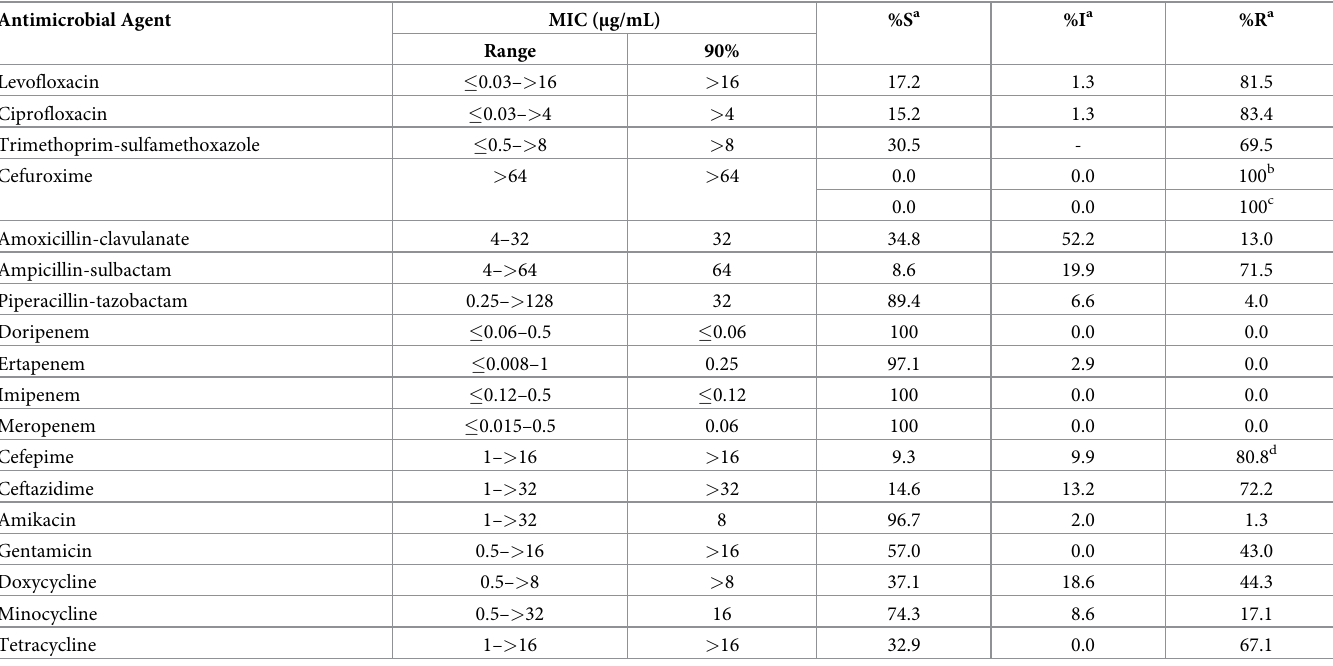
Table 3. Activity of antimicrobial agents against confirmed CTX-M-15 β -lactamase-producing isolates of E . coli collected from UTIs in the USA during 2017. Antimicrobial